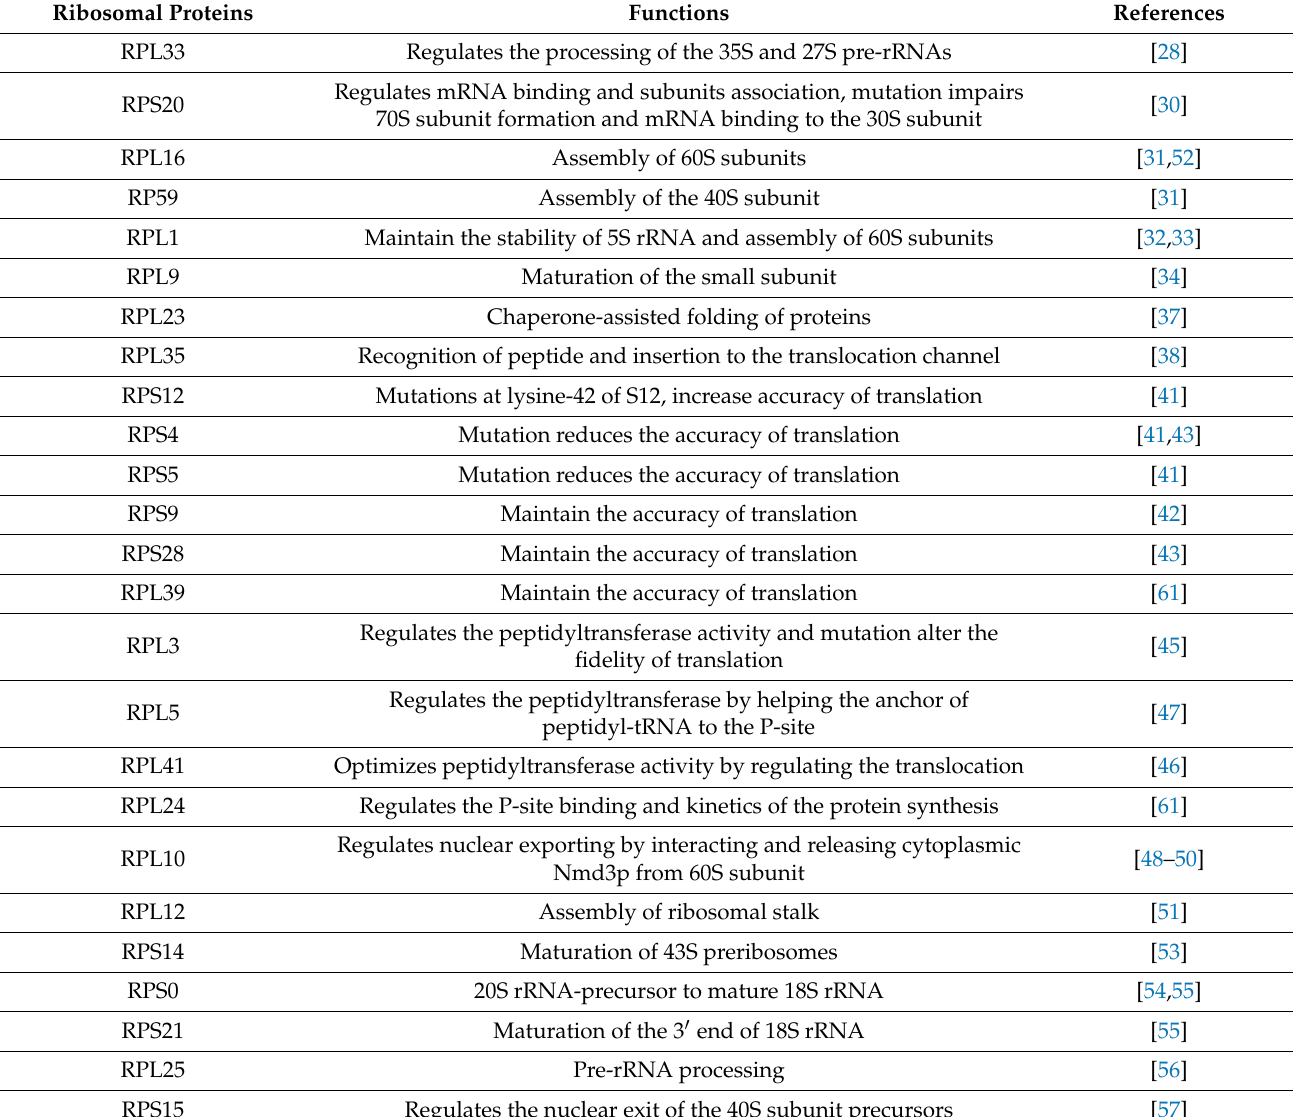
Table 2. Ribosomal proteins on the biogenesis and assembly of ribosomes, and translation of proteins. Ribosomal Proteins